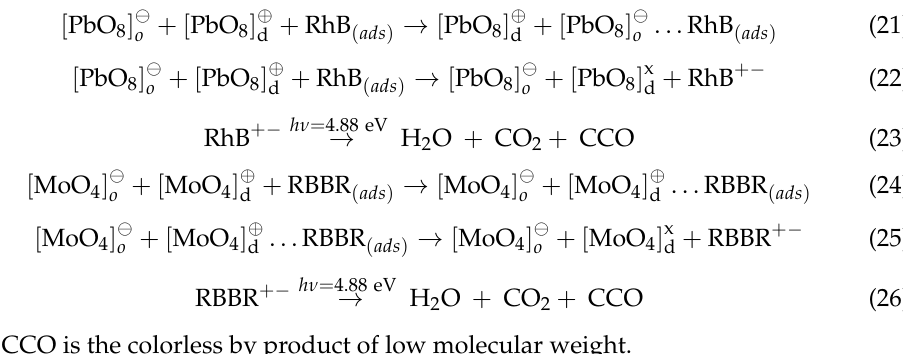
Figure S3: Electronic spin density isosurfaces of (a) stoichiometric PbMoO 4 in the spin-polarized triplet solution and (b) the supercell of reduced PbMoO 3.94 , where only the local symmetry is broken with the oxygen vacancy ( V 0 ) formation. Figure (a) shows that the conventional unit cell was replicated in the [100] plan; Table S1: Rietveld refinement results of PbMoO 4 nanocrystals; Table S2: Experimental and theoretical active Raman modes of PbMoO 4 nanocrystals synthesized and reported by the literature; Table S3: Lattice parameters (Å and Å 3 ), total energy differences per unit cell (eV) and electronic band gap (eV) of stoichiometric and reduced PbMoO 4